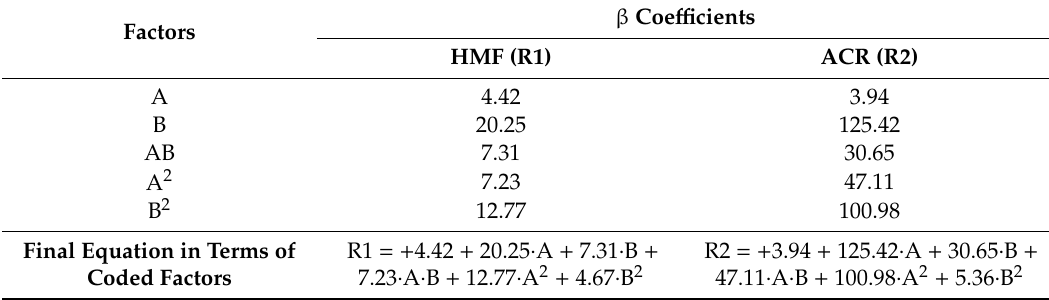
Table 5. The β coe ffi cients and the final equation in terms of coded factors for the model Table 5. The β coefficients and the final equation in terms of coded factors for the model chosen.